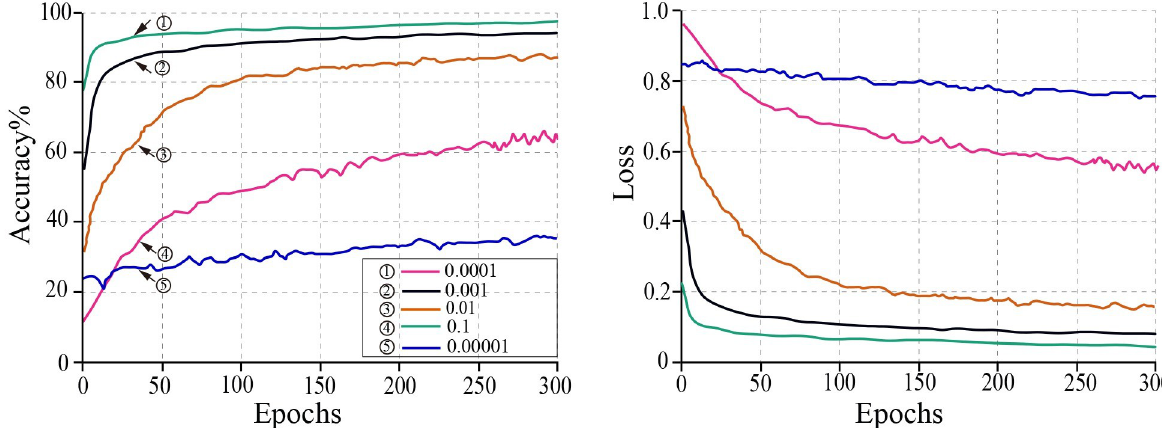
Fig 8. Effects of learning rate on training accuracy and training